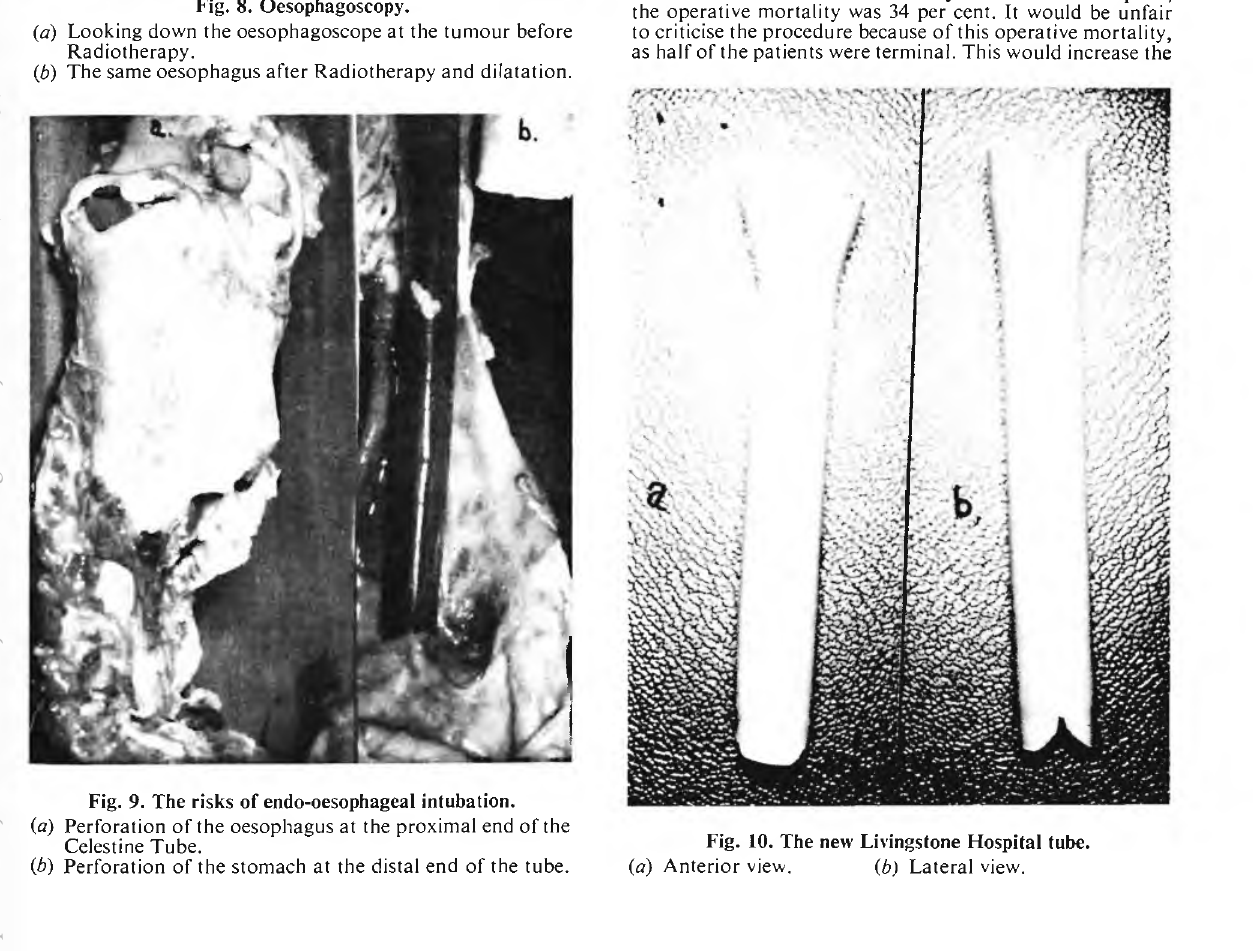
Fig. 9. The risks of endo-oesophageal intubation.